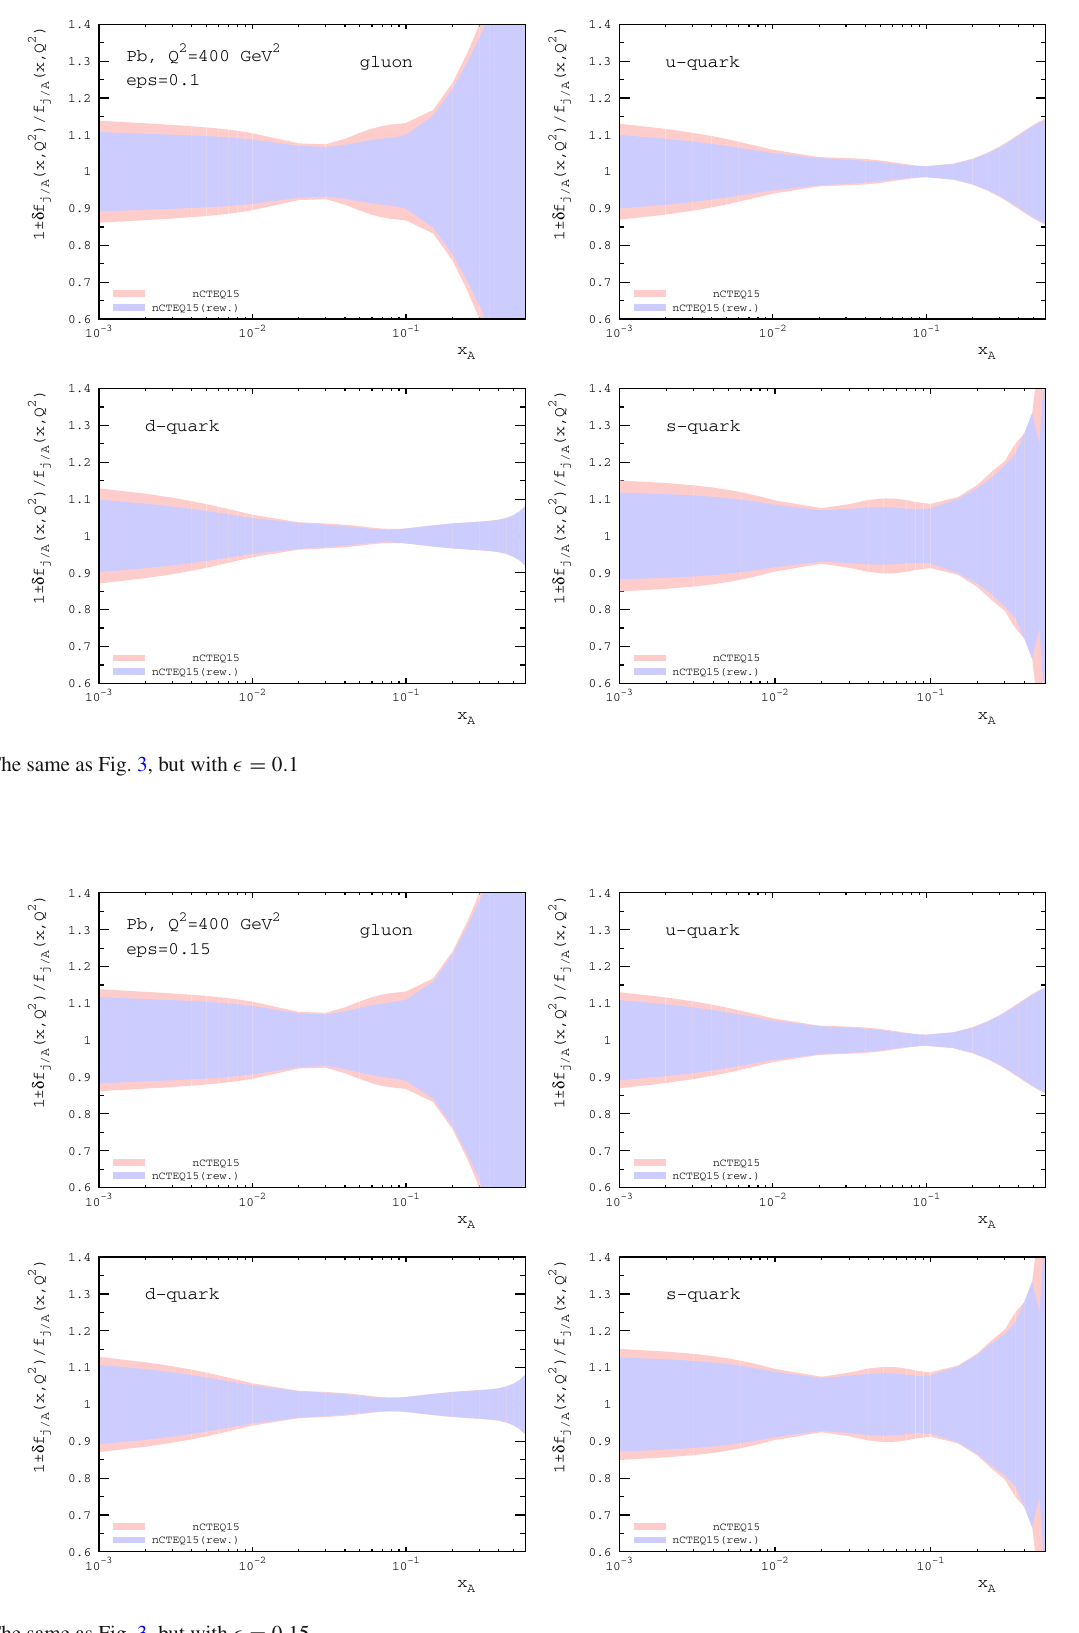
Fig. 4 The same as Fig. 3, but with (cid:6) = 0 .